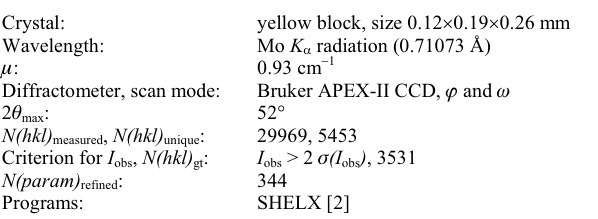
Table 1. Data collection and handling.